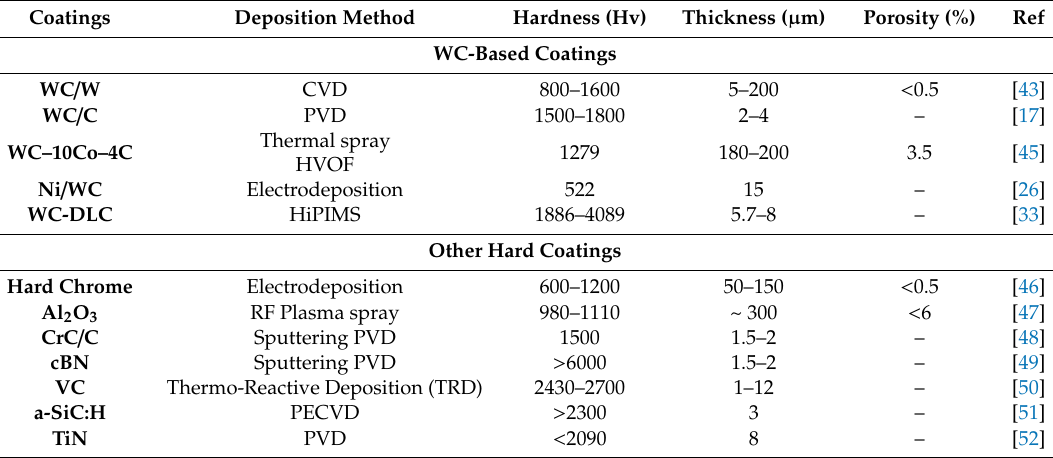
Table 2. Film characteristics and typical deposition method of widely available WC-based and comparable hard